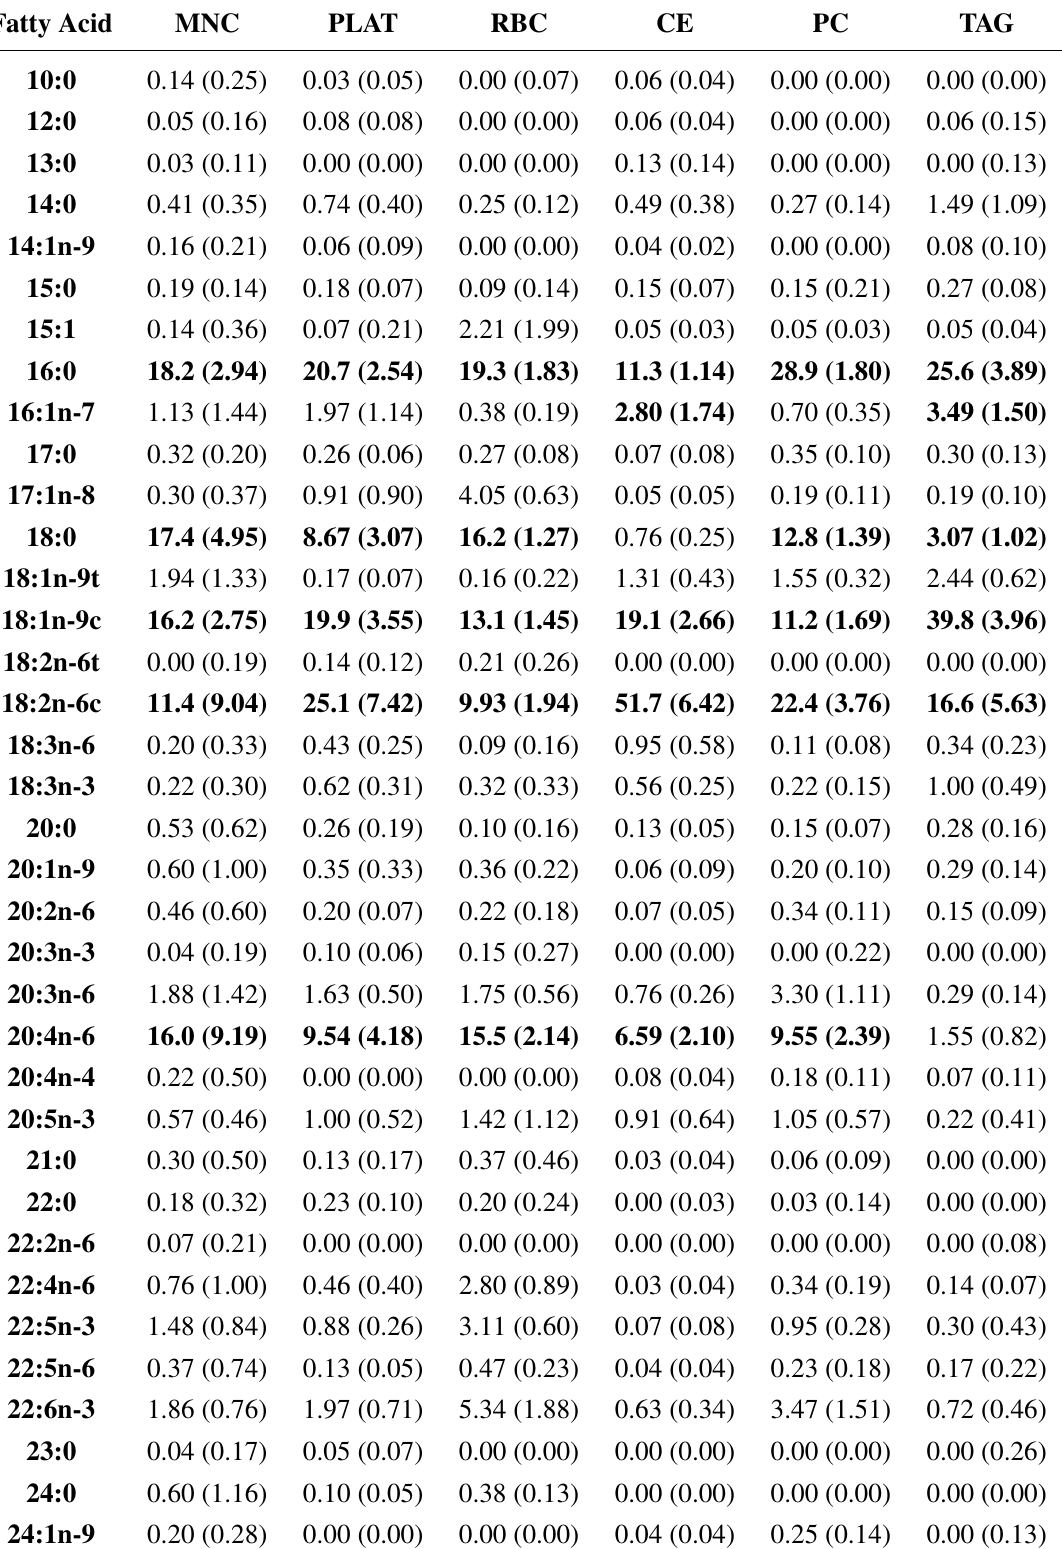
Table 1. Relative abundance of fatty acid (FA) in each lipid pool at